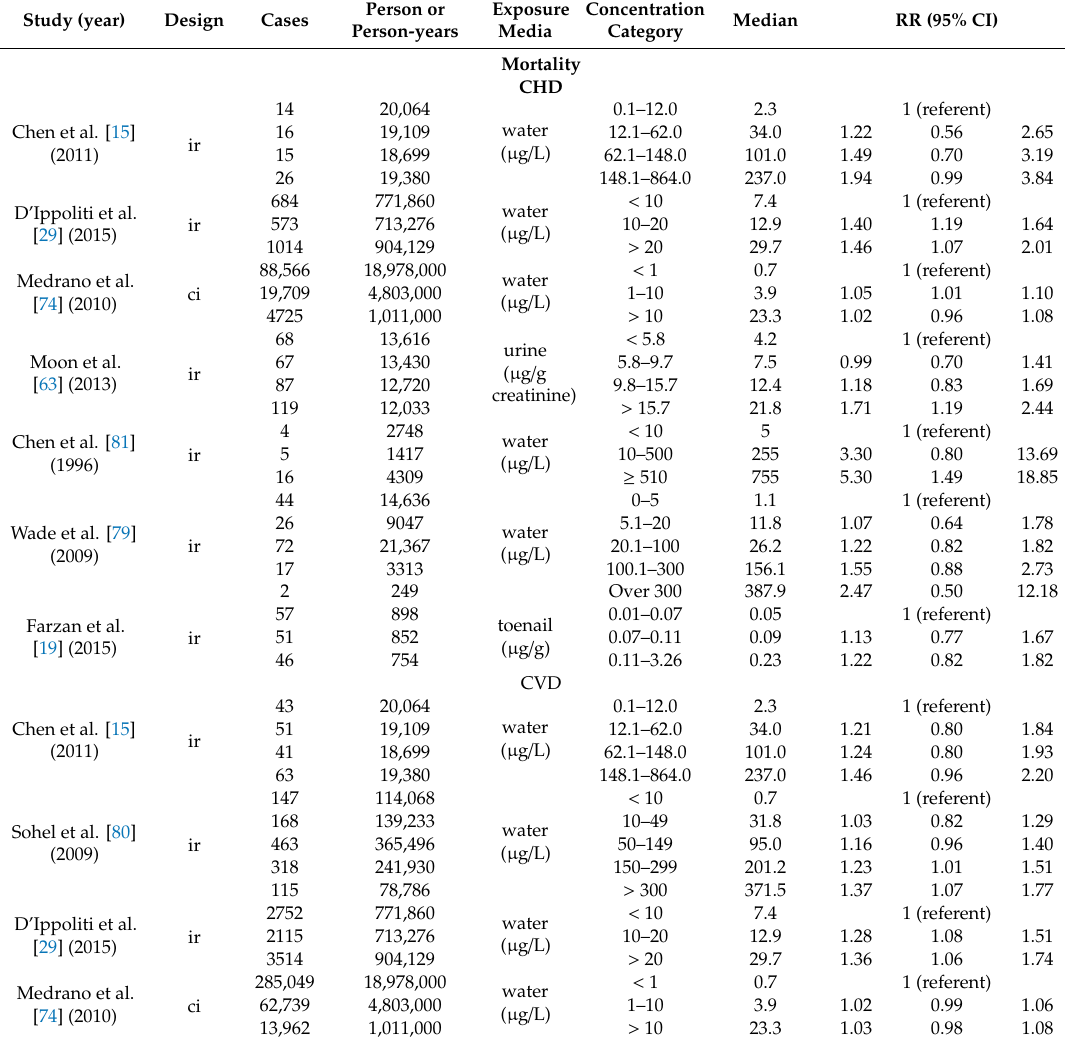
Table 1. Characteristics of studies included for dose-response